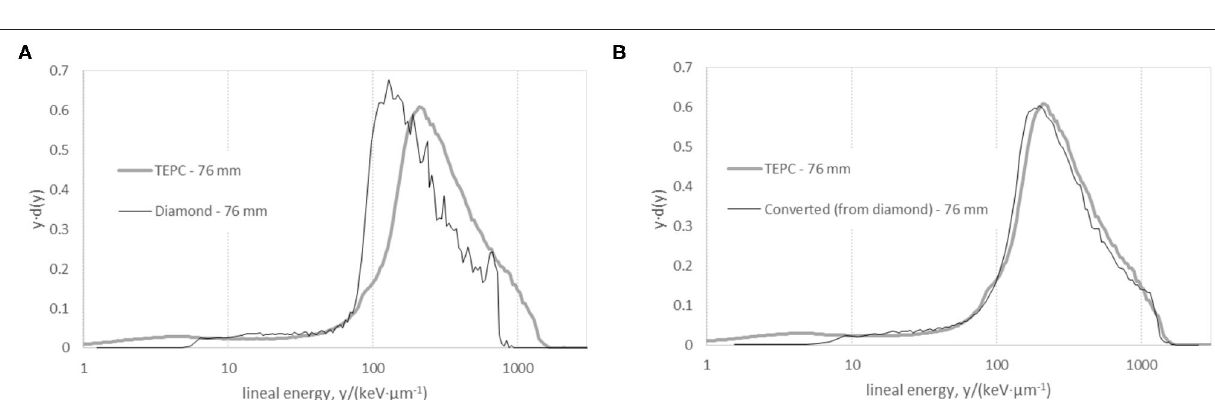
variability of radiation quality across the conjunctiva. To answer these questions, a microdosimetric approach was